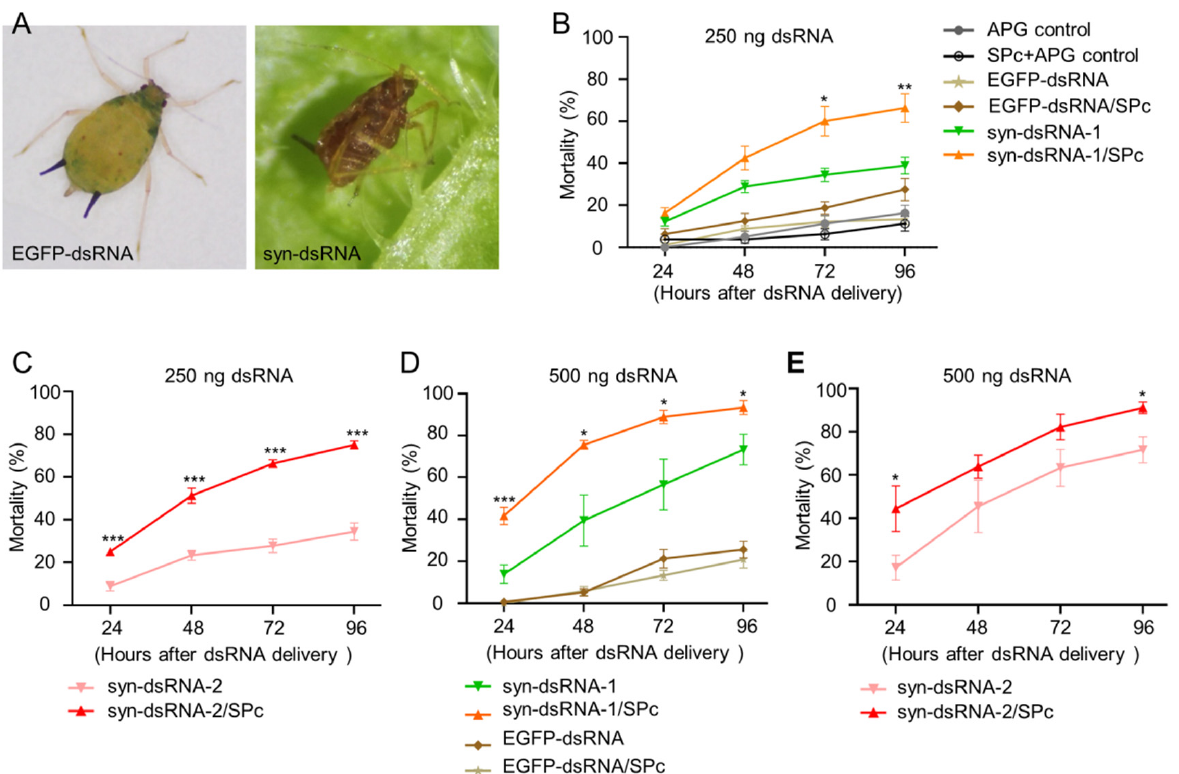
Figure 4. The lethal effect of syn - dsRNA. ( A ) An example of a viable melon aphid treated with EGFP-dsRNA and one treated with syn-dsRNA. ( B , C ) The delivery of 250 ng syn-dsRNA resulted in lethality to melon aphids. ( D , E ) The delivery of 500 ng syn-dsRNA resulted in lethality. SPc enhanced the mortality caused by syn-dsRNA. * indicates the significance by pairwise comparison of mortality between syn dsRNA/SPc and non-SPc treated aphids at each time point (Student’s t -test, *** p < 0.001, ** p < 0.01, and * p < 0.05).